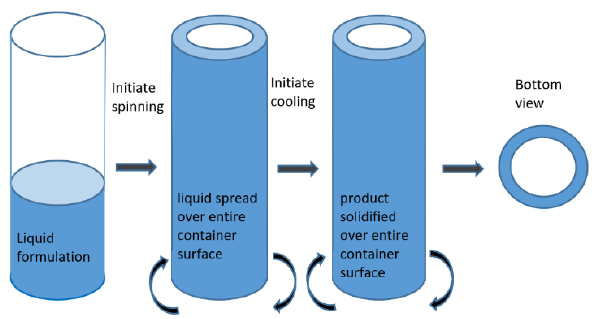
Figure 2. A method of increasing the evaporation surface and reducing the layer thickness in the spin freezing process; adopted from [35].